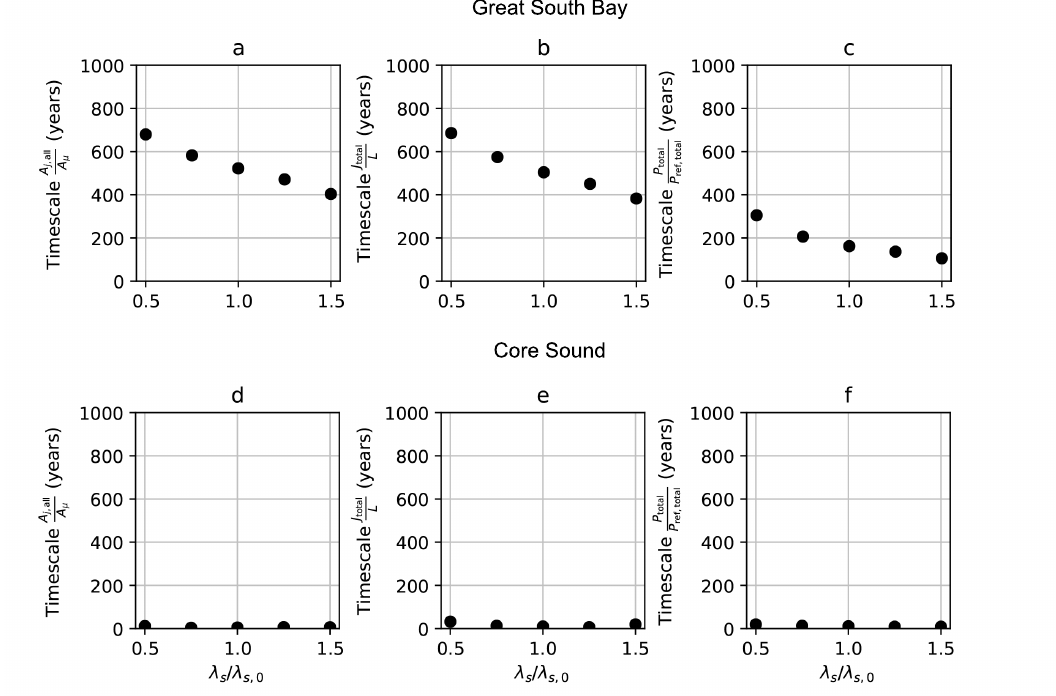
Figure 7. Effect of changes in storm frequency for the Great South Bay (top) and Core Sound (bottom) sets of parameter values (see Table 1). The timescales required to reach 90% of the final value of the same three metrics as in Figure 5 are plotted while storm frequency λ s is changed between − 50% and +50%. Shown are the timescales for: the ratio A j ,all / A µ ( a , d ); the number of open inlets per km barrier coast J total / L ( b , e ); dimensionless total tidal prism P total / P ref,total ( c , f ). N.B. the timescales for λ s / λ s,0 = 1.0 corresponds to the dashed lines in Figure